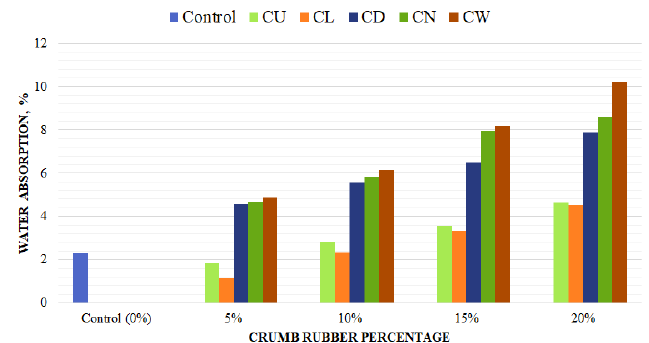
Figure 3. Water absorption at 7 days.